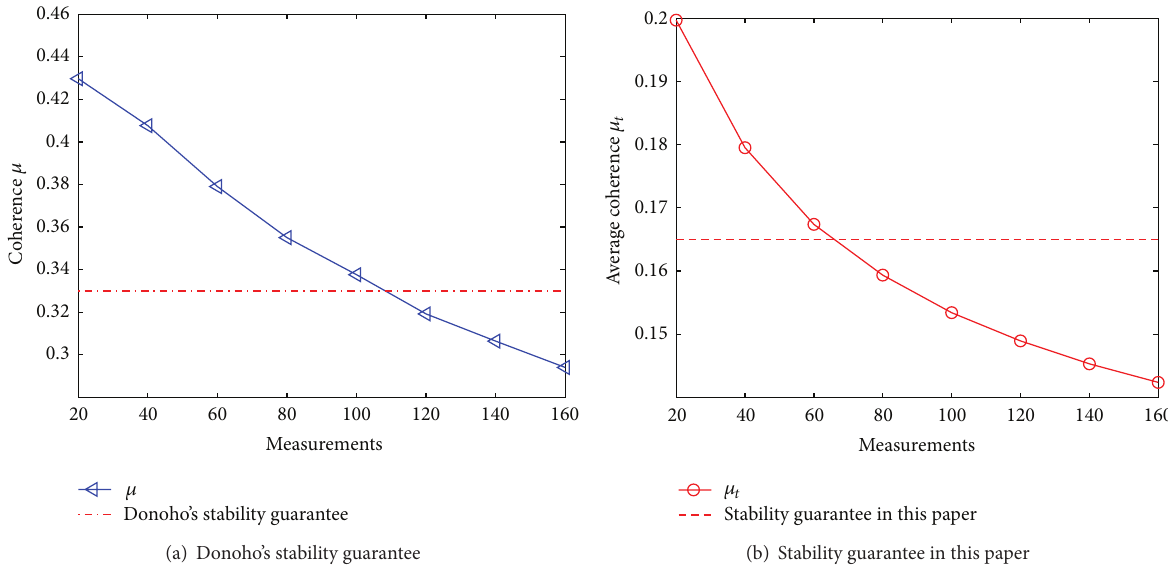
Figure 5: Coherence 𝜇 and average coherence 𝜇 𝑡 of the sensing matrix of different number of measurements with the different stability guarantee.